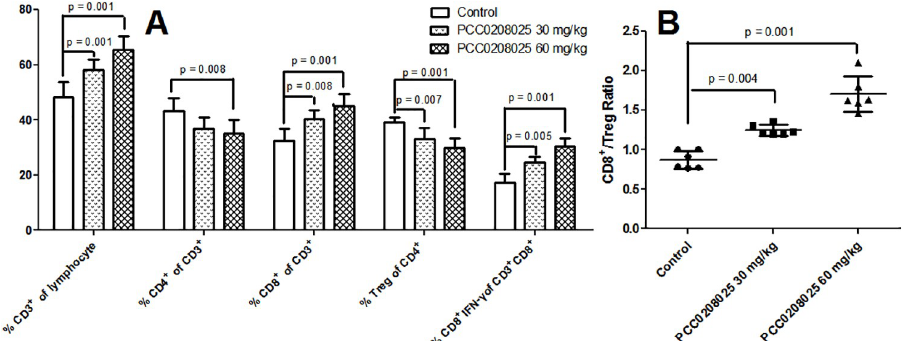
Fig 7. Effects of PCC0208025 on T cell subsets from tumor in B16-F10-bearing mice. The percentage of CD3 + , CD3 + CD8 + or CD8 + IFN- γ + T cells was markedly increased in PCC0208025 groups compared with the control group (each treatment P < 0.05 for each T cell, respectively, n = 6) (A). And, The significant decreases in the percentage of CD3 + CD4 + T cells were observed in PCC0208025 60 mg/kg group compared with the control group ( P < 0.05, n = 6) (A). However, the percentage of CD4 + CD25 + CD127 low/- (Treg) was significantly decreased by 30 mg/kg and 60 mg/kg of PCC0208025 compared with the control group (each treatment P < 0.05, respectively, n = 6) (A). Furthermore, in PCC0208025 30 mg/kg and 60 mg/kg groups, the ratios of CD8 + /Treg (B) were significantly increased compared with the control group (each treatment P < 0.05, respectively, n = 6). The results were presented as mean ± SD. � P < 0.05 compared with control group.